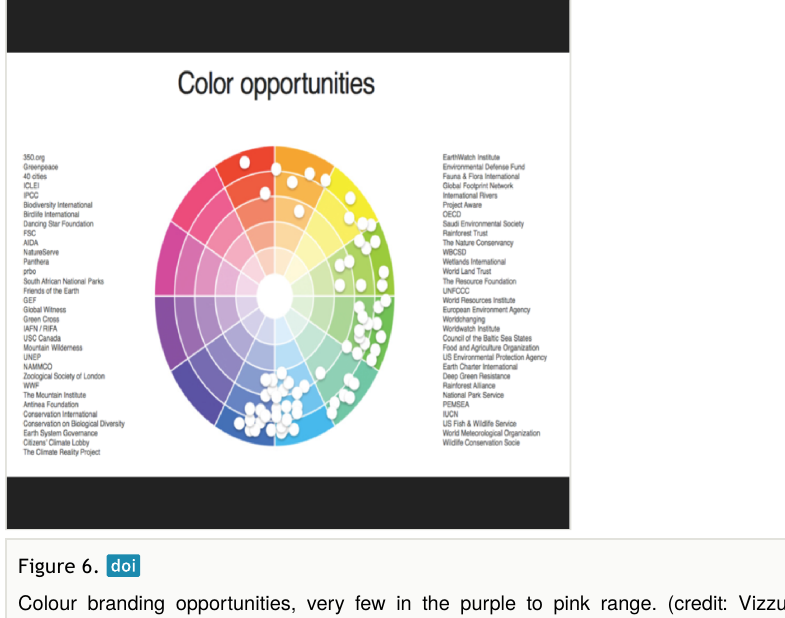
Figure 6. Colour branding opportunities, very few in the purple to pink range. (credit: Vizzuality as presented by Craig Mills, CEO,